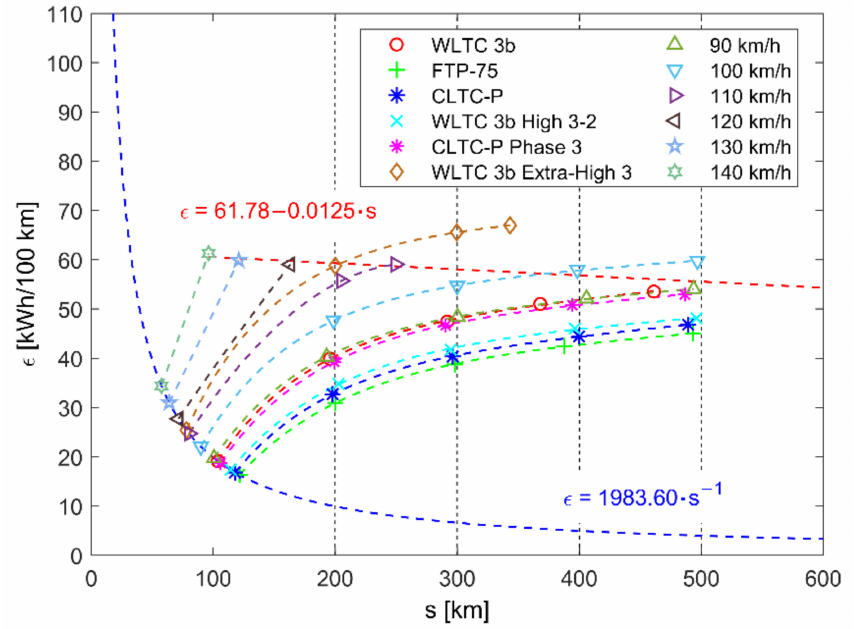
Figure A16. Specific energy consumption results for BEV mode and EREV drive (four EREV range targets indicated with dashed vertical lines) in various drive cycle conditions. Vehicle mass is equal to 2100